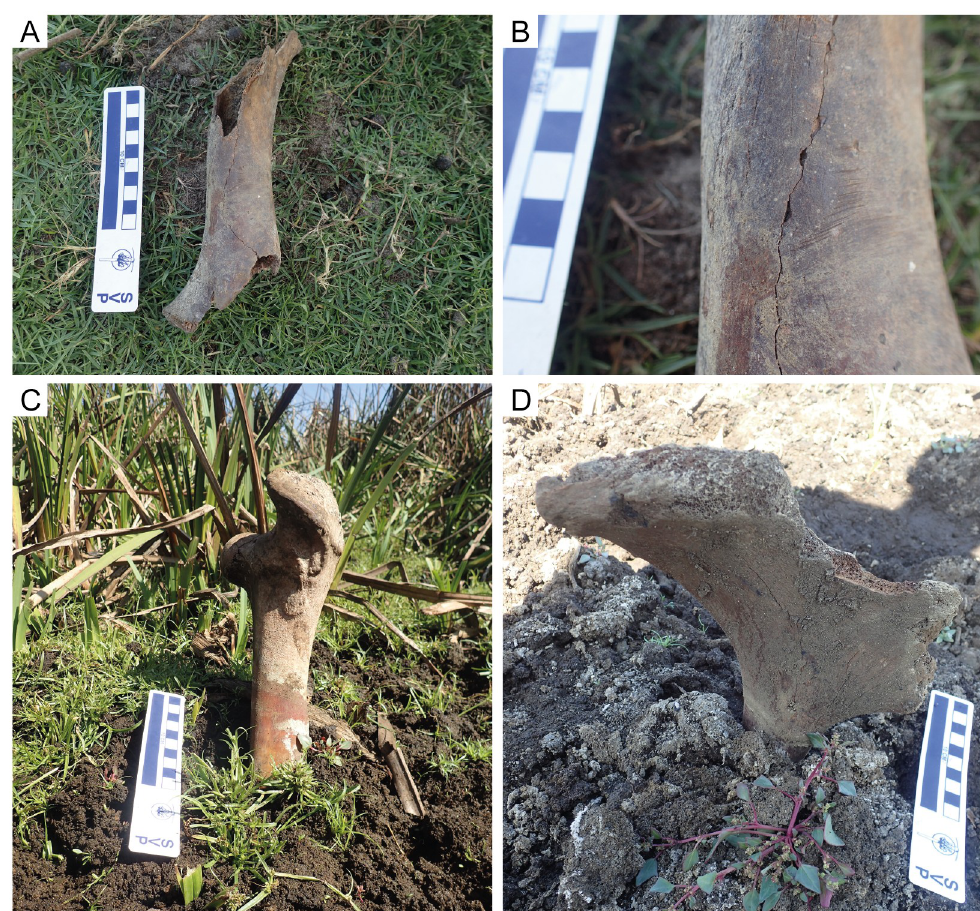
Fig 6. Trampled bones in the lake-margin habitat. (A) Cow or horse humerus with trampling marks. (B) Close-up view of (A) where the fine, parallel scratches produced by trampling are visible. (C) Cow femur half buried and displaying a near-vertical orientation. (D) Cow innominate half buried and displaying near-vertical orientation.